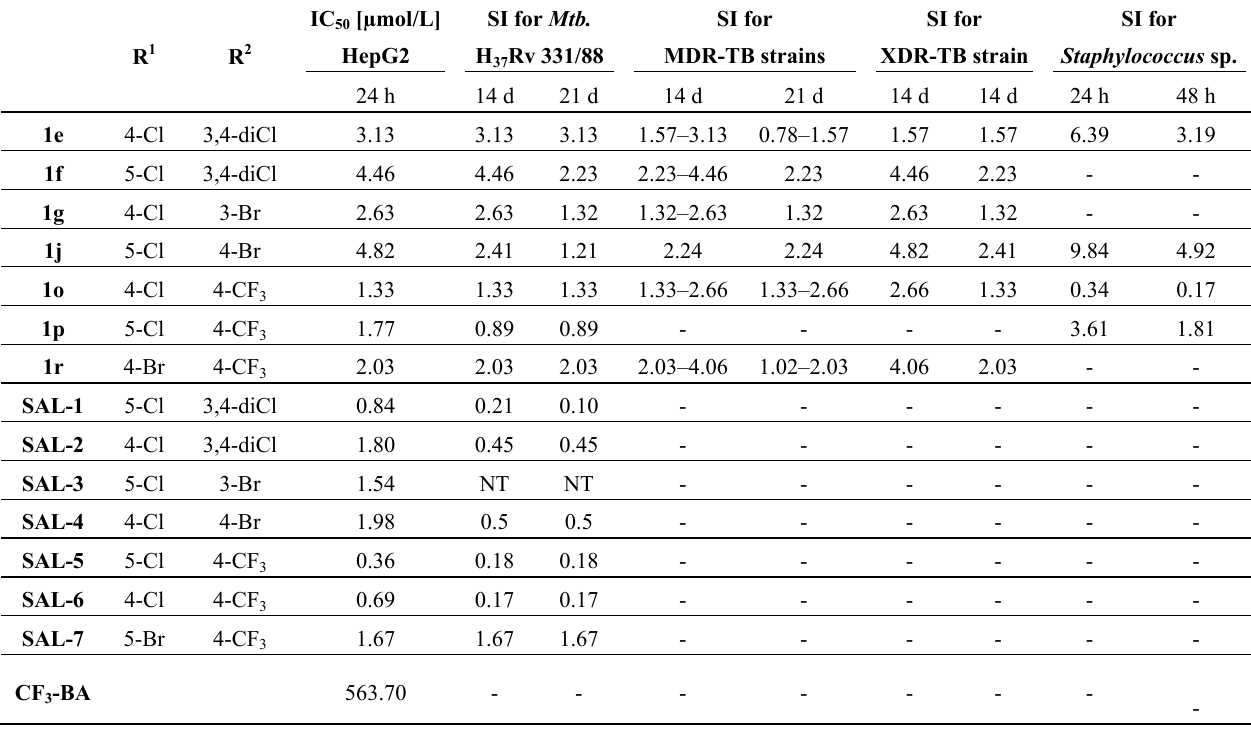
Table 5. IC and SI for selected salicylanilide 4-(trifluoromethyl)benzoates 1 50